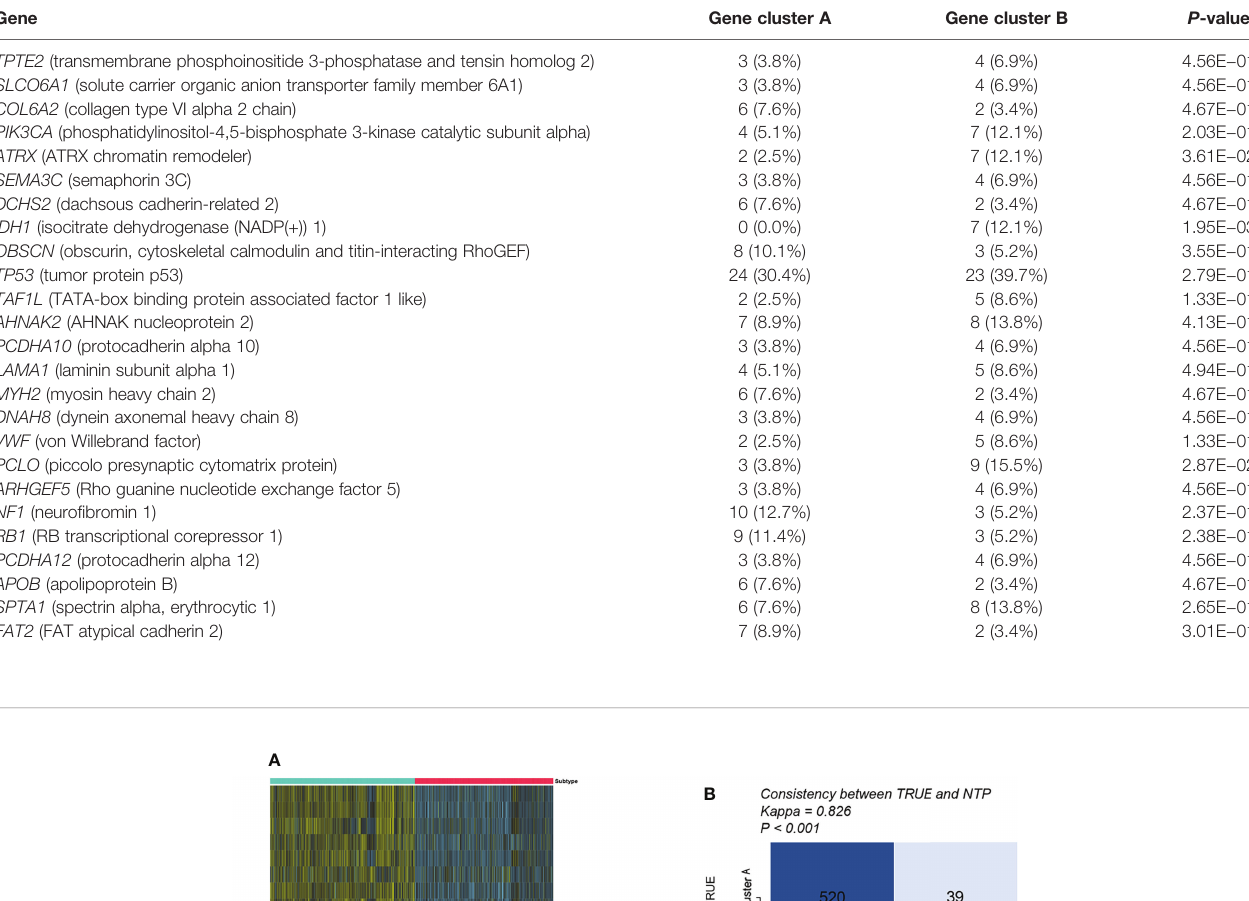
TABLE 1 | Association of different subtypes with somatic variants. Gene Gene cluster A Gene cluster